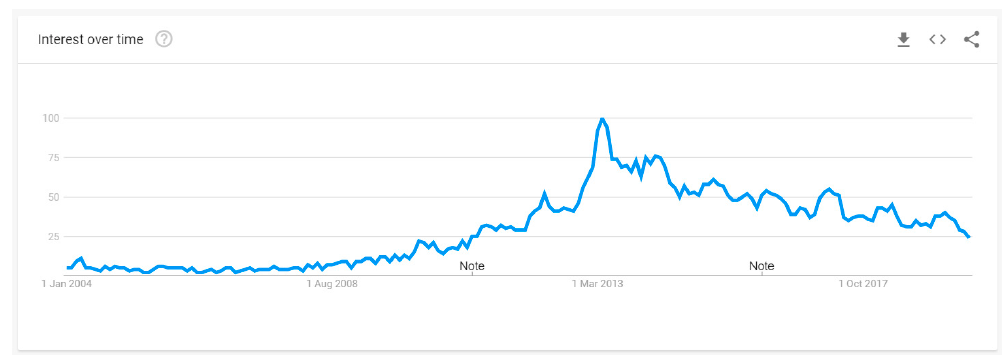
Figure 2. Google Trends for the term “aquaponics” (accessed on 7 August 2019) [21].